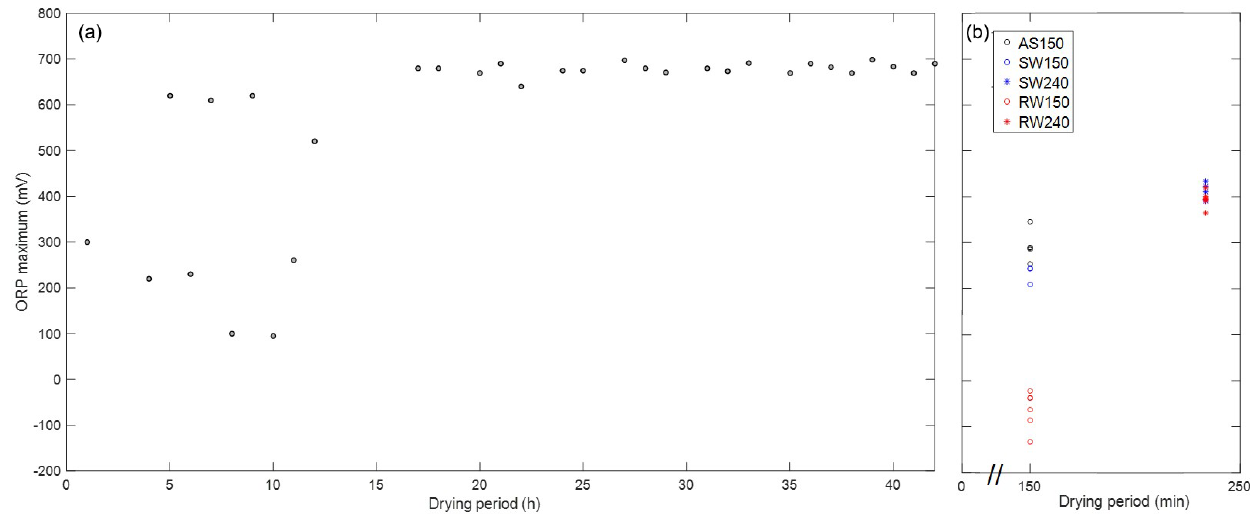
Figure 5. Maximal OPR values versus DP length (a) during field infiltration campaigns at the SHAFDAN site (at 95cm depth) and (b) during the column experiments AS, SW150/240, RW150 and